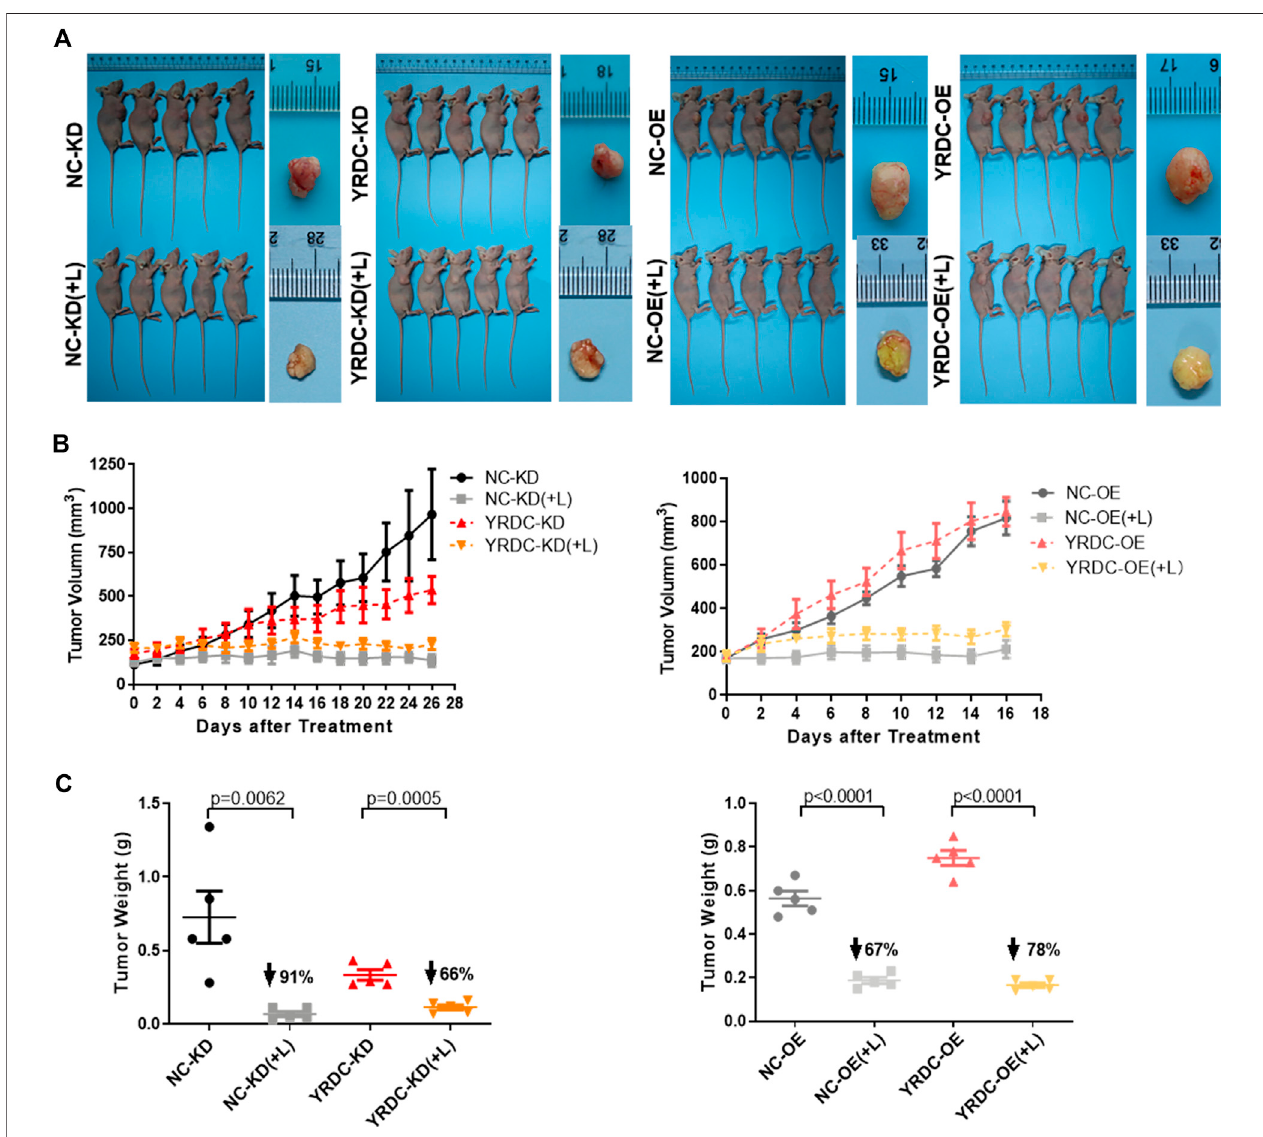
FIGURE4| Theeffectsoflenvatinibontumorgrowth invivo aresigni fi cantlycorrelatedwiththeexpressionlevelofYRDC. (A) The invivo growthofxenografttumors was signi fi cantly inhibited by lenvatinib at a dose of 30 mg/kg in all Huh7 cell models. (B) The tumor growth curves of YRDC knockdown or overexpression and their control cells after lenvatinib. (C) The difference oftumor weight with YRDC knockdown or overexpression cells after lenvatinib was compared with their controls. Dots in the graphs mean biological repetitions, n (cid:2) 5.